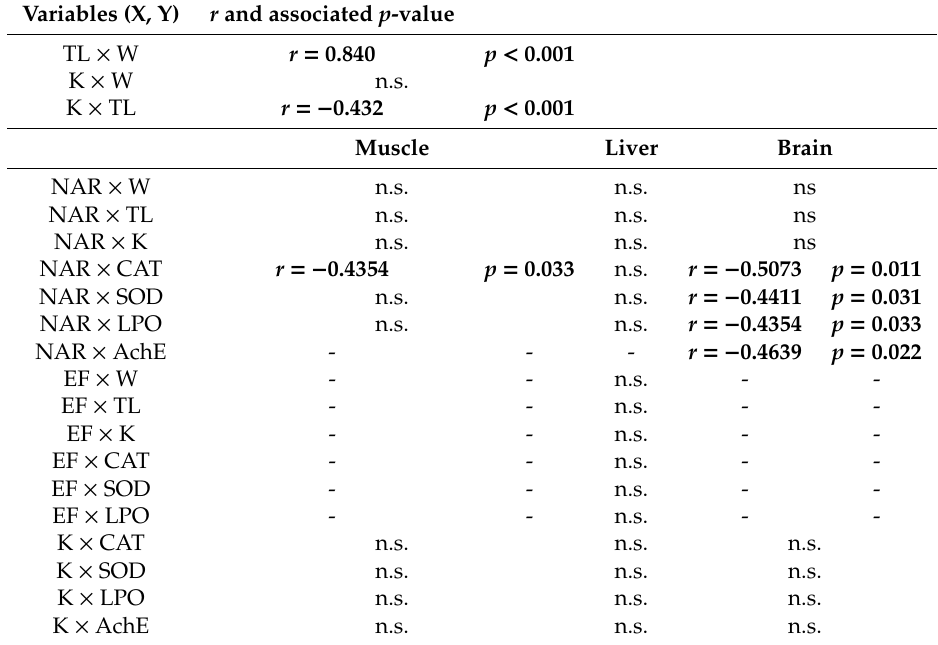
Table 5. Pearson’s correlation coe ffi cients ( r and associated p -value) among Hg NAR, EF, and biochemical responses in the di ff erent tissues, as well as animal morphometry and condition (K). Variables (X, Y) r and associated p -value TL × W r =